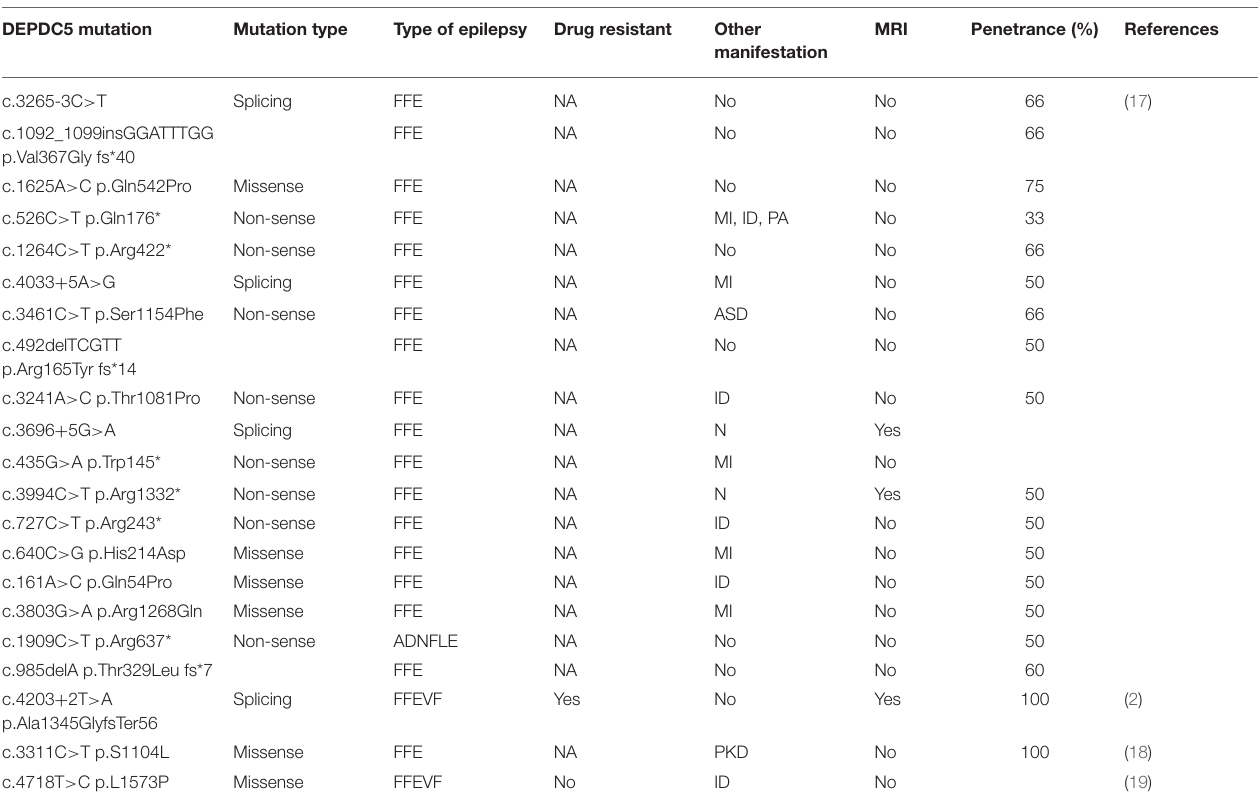
FFEVF, familial focal epilepsy with variable foci; FFE, familial focal epilepsy; ADNFLE, autosomal dominant sleep-related hypermotor epilepsy; FTLE, familial temporal lobe epilepsy; RE, Rolandic epilepsy; NA, not available; Y, yes; N, normal; ASD, autism spectrum disorder; ID, intellectual disability; PD, psychiatric disorder; DD, developmental delay; MI, migraine; PA, parasomnias; FCD, focal cortical dysplasia; PKD, paroxysmal kinesigenic dyskinesia. *